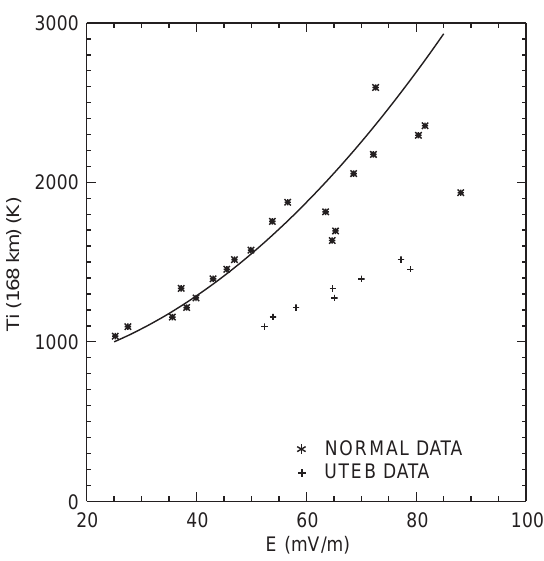
Fig. 5. Parallel ion temperature (long pulse) at 168 km as a function of observed electric field strength for normal events ( star symbols ) and for UTEB events ( crosses ). The long pulse temperatures are 50–100 K greater than the multipulse values. The full line gives the computed parallel ion temperature value in the absence of